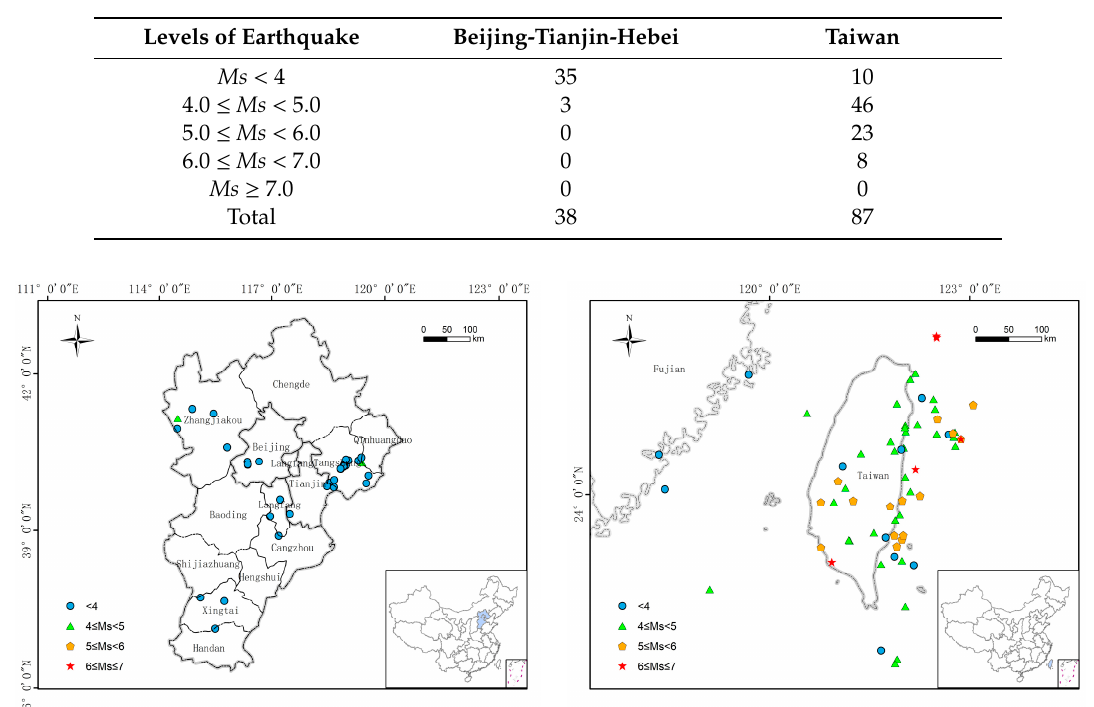
Table 7. Classification statistics of earthquakes from news reports in the Beijing-Tianjin-Hebei region and in Taiwan province.